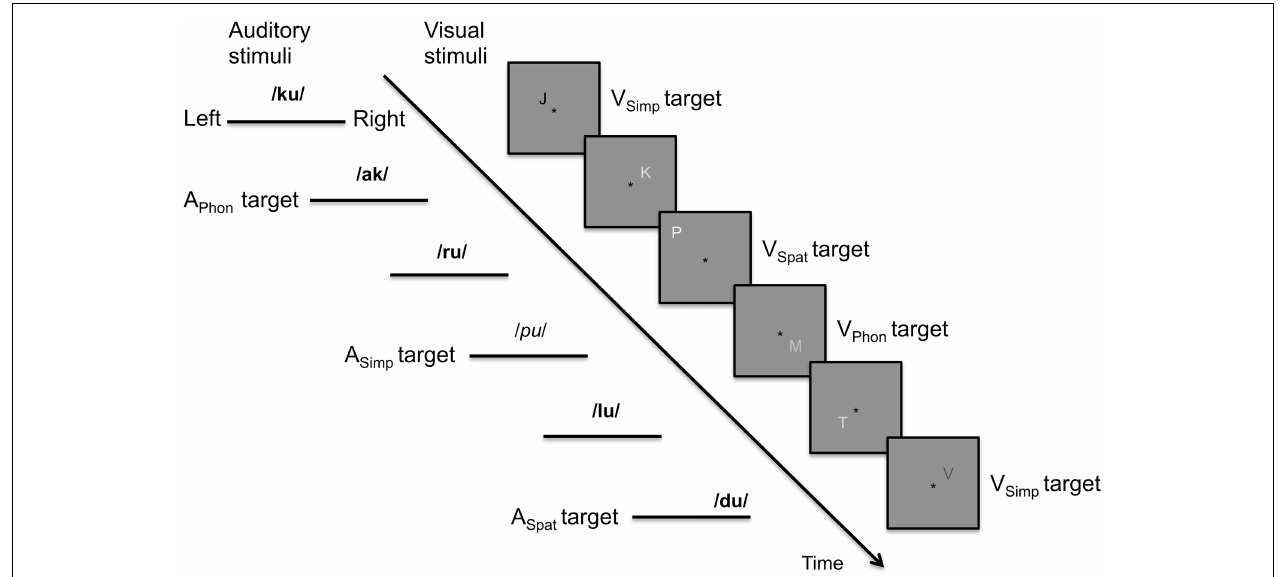
FIGURE 1 | Schematic illustration of the auditory and visual stimulus streams in the present study. In the auditory stream, the targets in phonological, spatial, and simple tasks were syllables starting (vs. ending) with a vowel, presented at the left or right lateral (vs. central) loci or spoken by a female (vs. male) voices. In the figure, female and male voices are